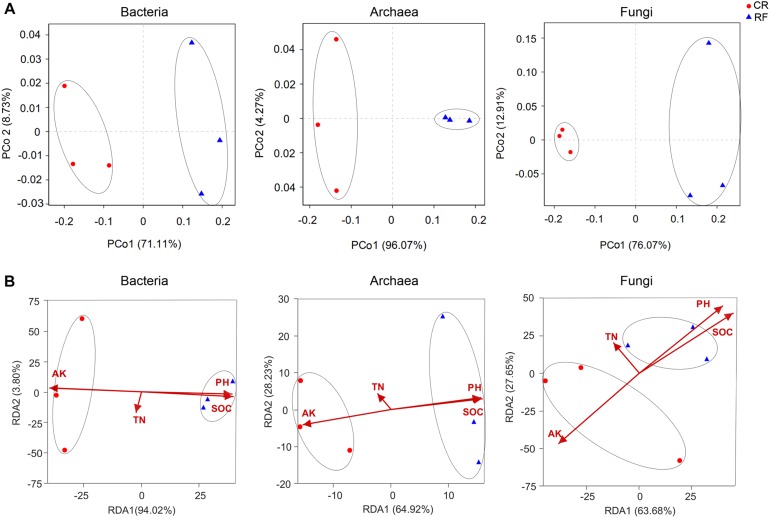
(A) Principal coordinates analysis (PCoA) of bacterial, archaeal, and fungal community variations between CR (conventional rice cultivation) and RF (rice-frog cultivation). (B) Redundancy analysis (RDA) based on Bray-Curtis dissimilarities of bacterial, archaeal and fungal communities and soil properties. AP, available phosphorus; TN, total nitrogen; pH, hydrogen ion concentration; SOC, soil organic C.